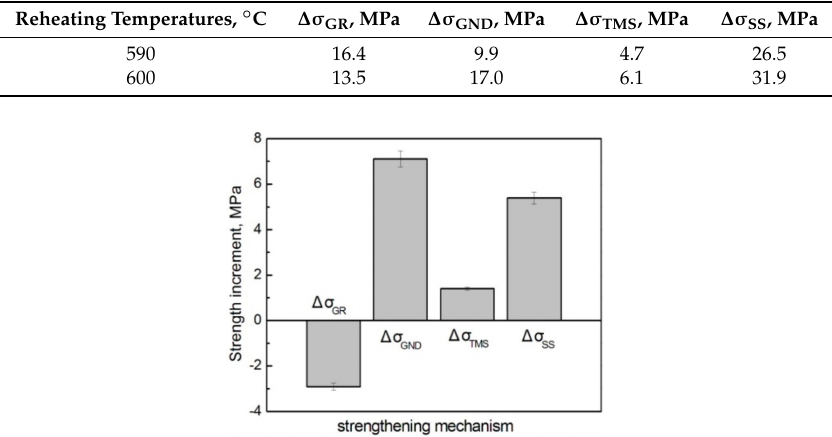
Figure 16. Strength increments from different strengthening mechanisms when the reheating temperature rises from 590 ◦ C to 600 ◦